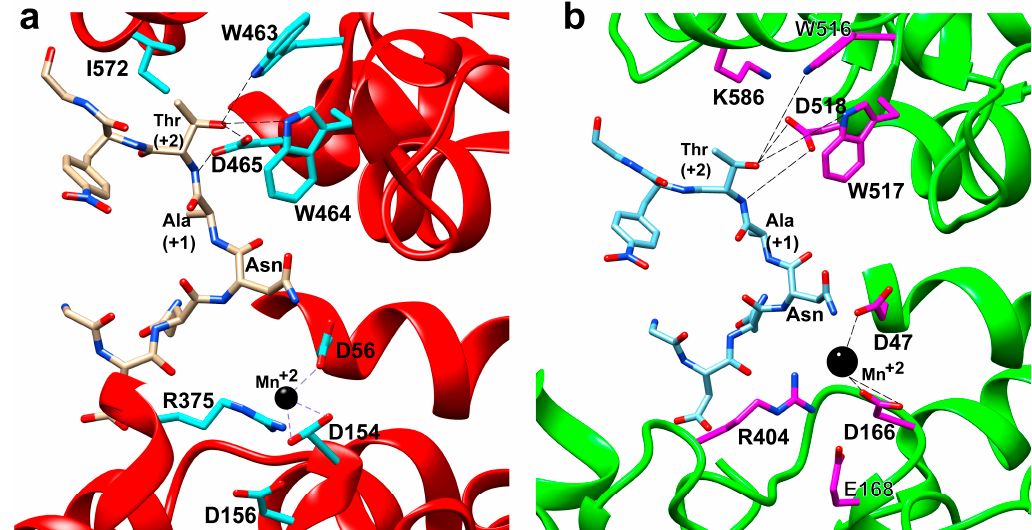
Figure 6. Active site of ( a ) bacterial PglB (PDB ID: 3RCE) and ( b ) yeast Stt3 (PDB ID: 6EZN), indicating the important residues involved in acceptor peptide recognition for glycosylation and metal ion co-ordination. Residues to metal co-ordination and H- bond of the WWD motif to +2 Thr of the acceptor peptide are shown with dotted lines.